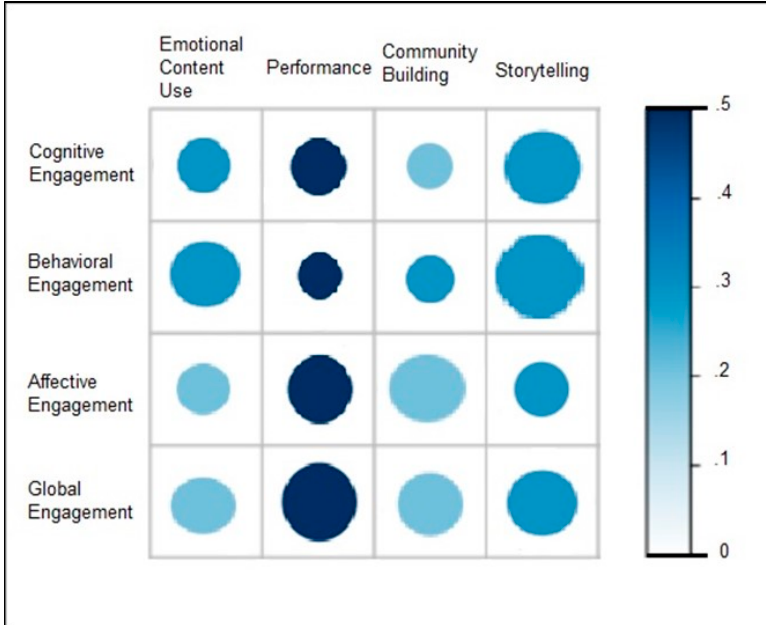
Figure 3. Correlation plot of faculty engagement and student engagement. Table 8. Logistic regression